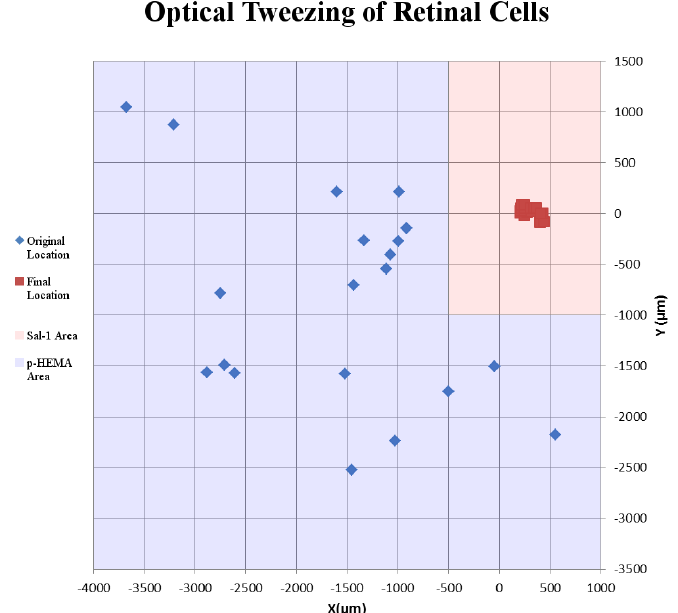
Figure 2. Example of the movement of retinal cells on a microelectrode array. Blue diamonds indicate original location where retinal cells were found in the p-HEMA-coated area. Red squares indicate final location of retinal cells tweezed onto MEA electrodes. Blue shaded squares indicate p-HEMA coating. Red shaded regions indicate Sal-1-coated areas.